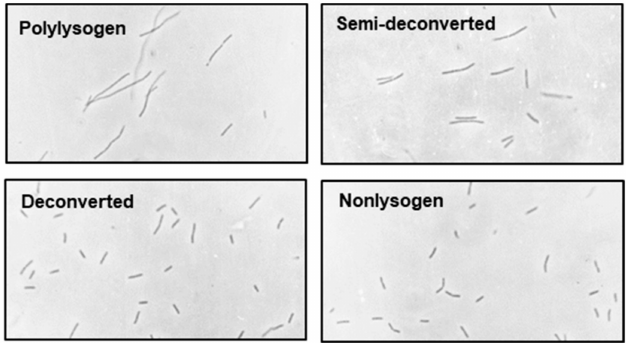
Figure 10. Photomicrographs of polylysogen at di ff erent stages of gradual deconversion, as labeled. Note that the fully deconverted cells are essentially indistinguishable from those of the